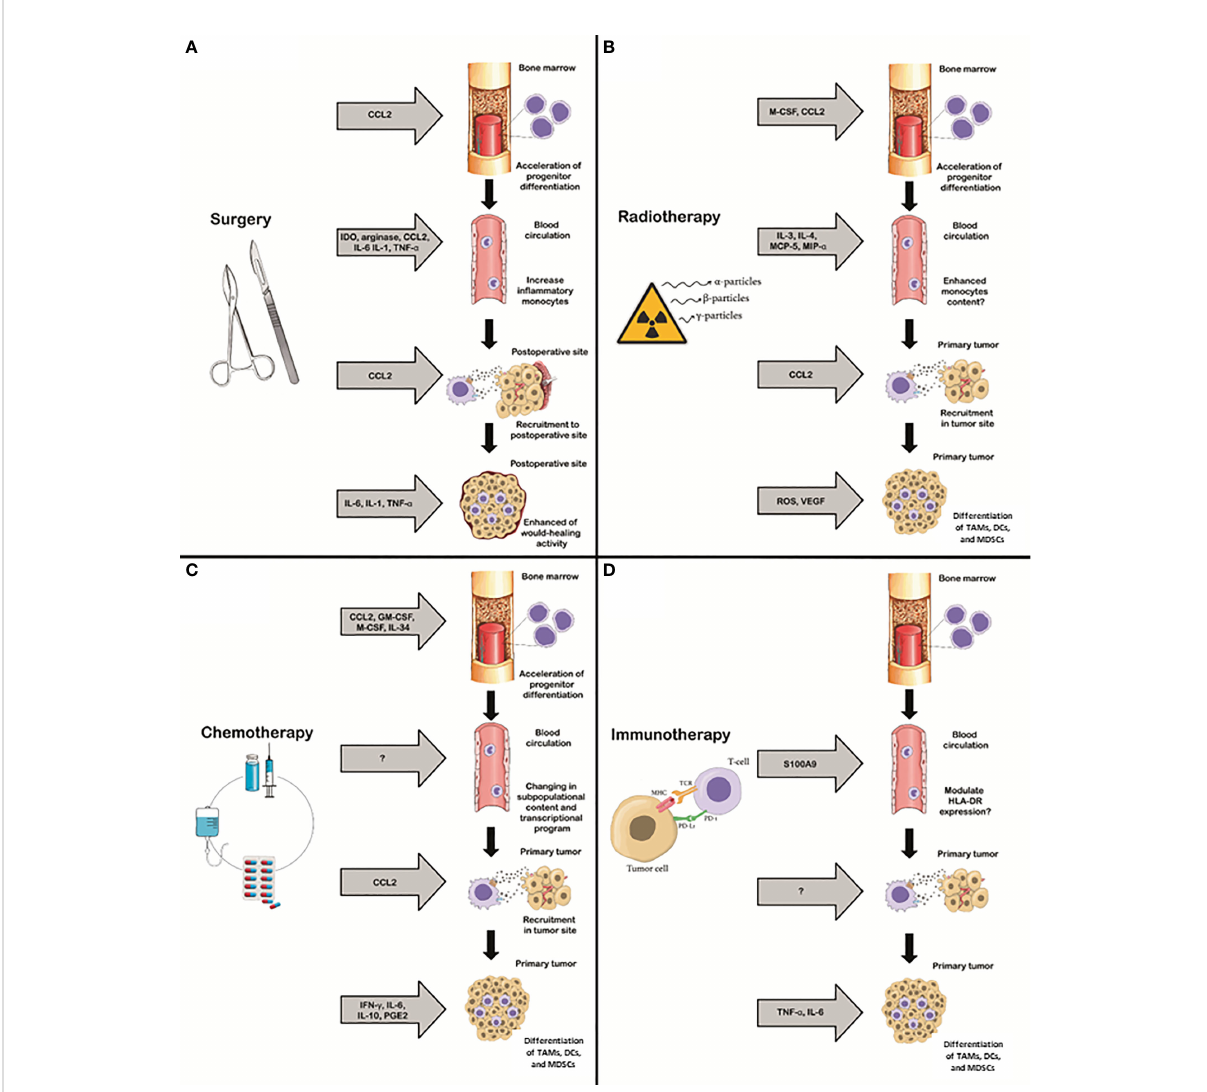
FIGURE 1 Interaction of four major types of cancer therapy with monocyte programming. Effects of surgery (A) , radiotherapy (B) , chemotherapy (C) and immunotherapy (D) on the differentiation of the monocyte progenitors in bone marrow, monocyte amounts and content in the circulation, recruitment to tumor and differentiation into TAMs are separately presented. Soluble mediators of the therapy effects are listed in the grey arrows. GM-CSF- Granulocyte-macrophage colony-stimulating factor, M-CSF - Macrophage colony-stimulating factor, CCL2 - Monocyte chemoattractant protein 1 (MCP1), IL1 – Interleukin1, IL3 – Interleukin 3, IL4 – Interleukin 4, IL6 – Interleukin 6, IL10 – Interleukin 10, MCP5 - Monocyte chemotactic protein 5 (CCL12), MIF a - Macrophage Migration Inhibitory Factor a , ROS - , VEGF - Vascular endothelial growth